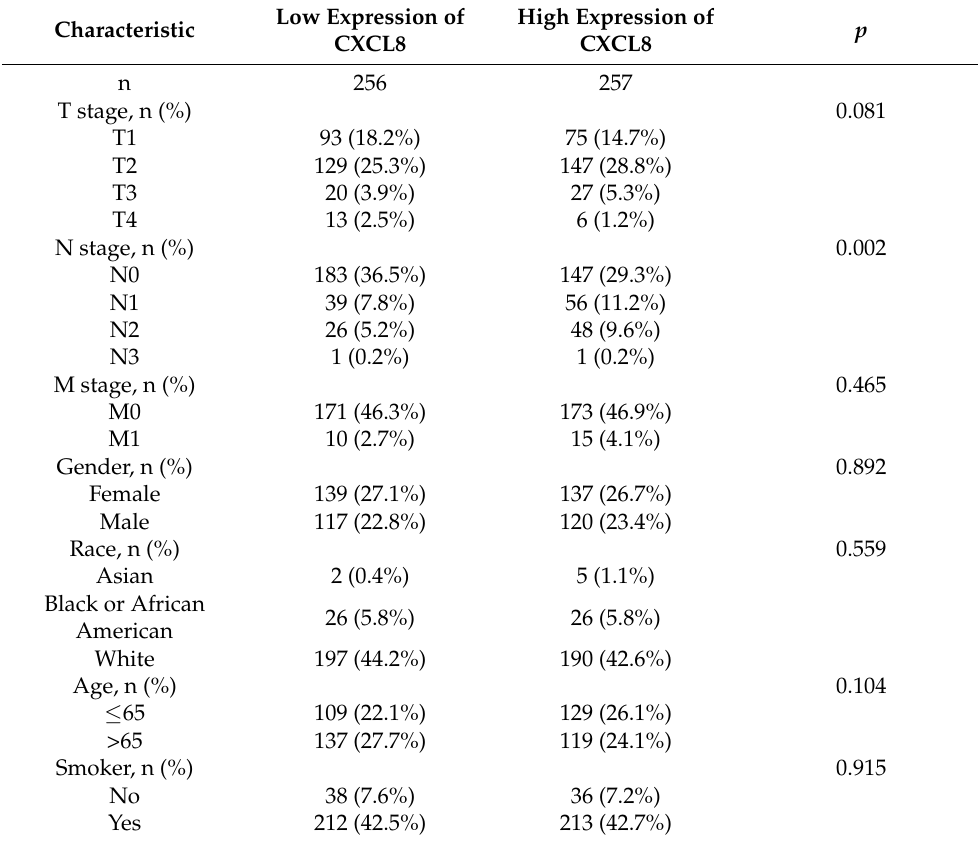
Table 4. Clinical information on CXCL8. The data for analysis were from the LUAD project in TCGA